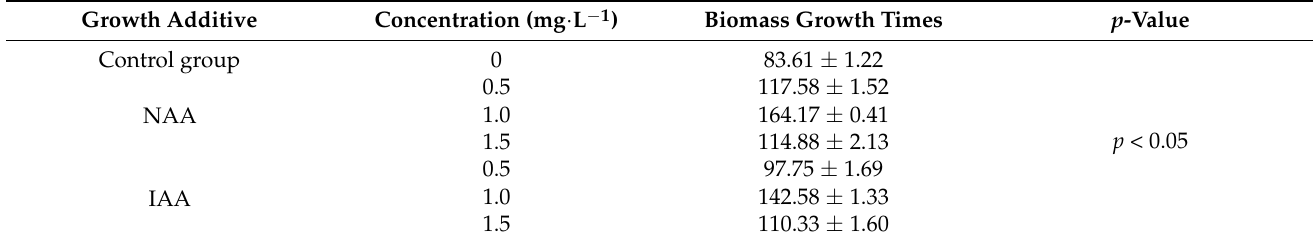
Table 3. Modification of medium used to proliferation culture H. serrata .